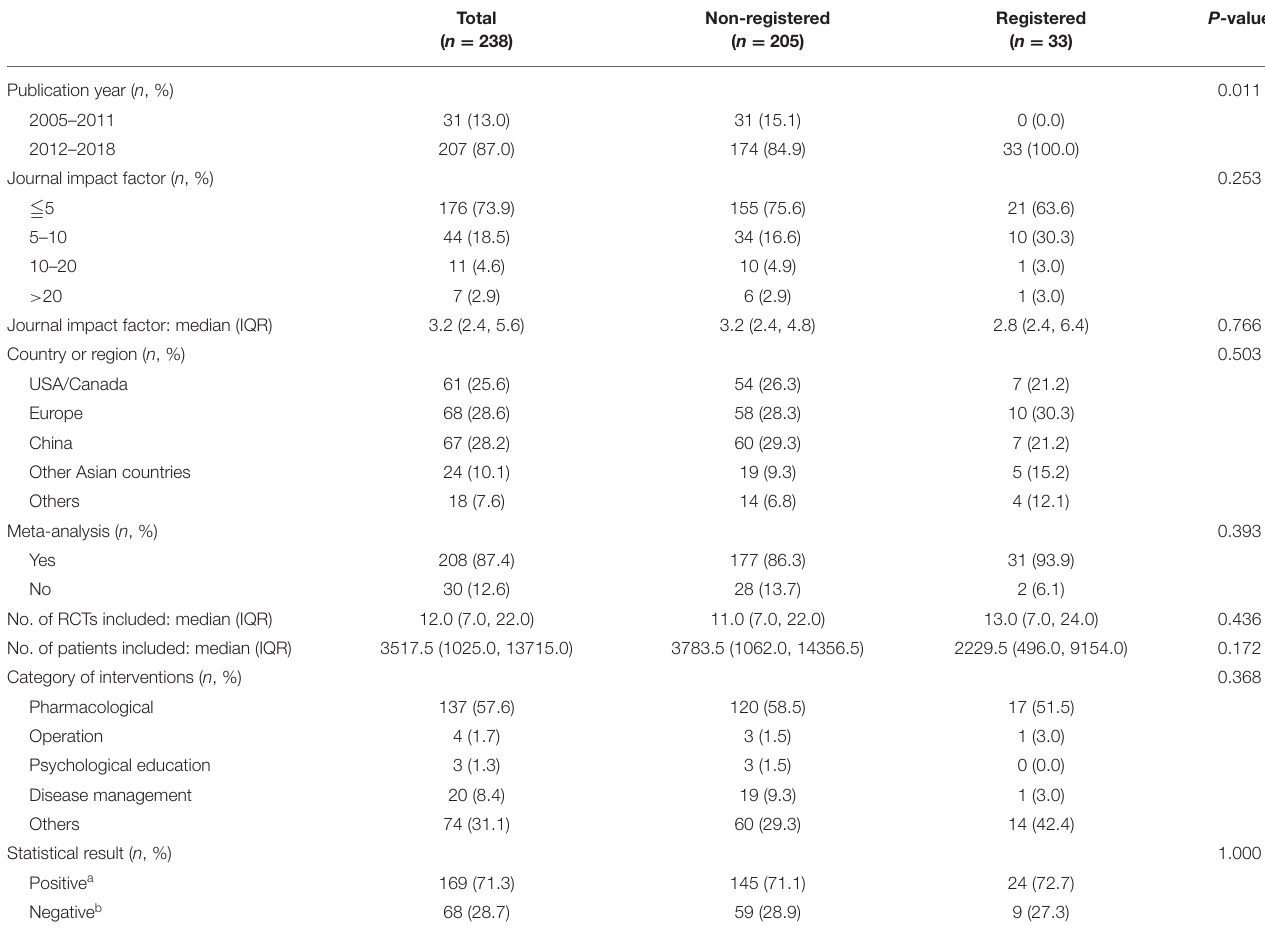
TABLE 1 | Characteristics of included systematic reviews in